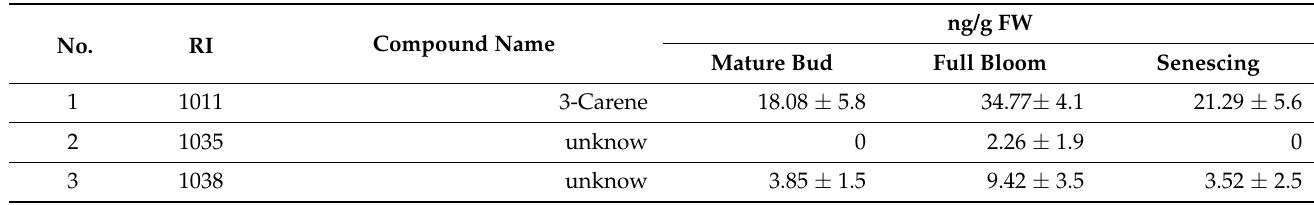
Table 5. Volatile organic compounds produced by P. ‘Endsleigh’ flowers at three different stages of development (mature bud, full bloom and senescing) and their semi-quantitative determination (ng/g FW). No.